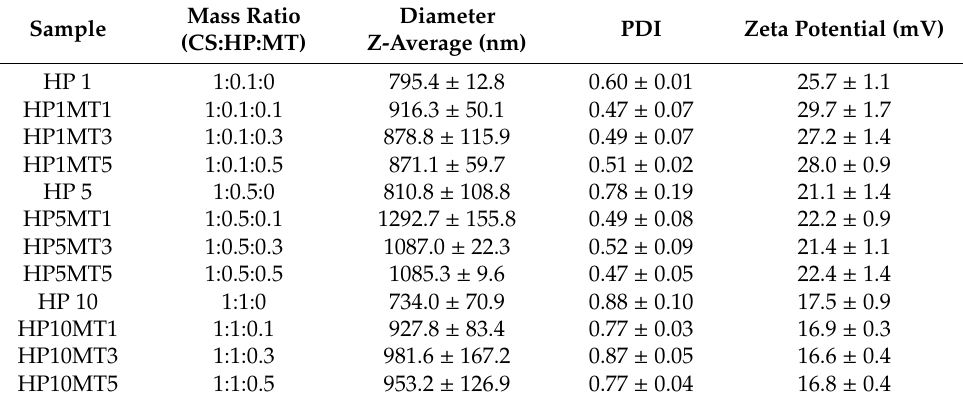
Table 3. Particle size, zeta potential, and PDI of nanoparticles containing MT prepared by method